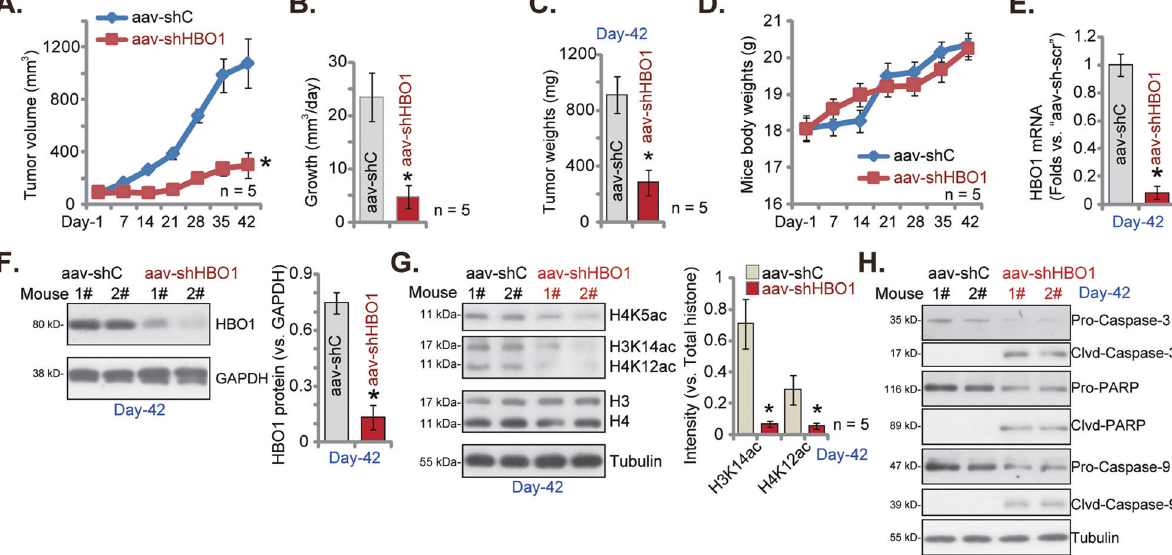
Fig. 8 HBO1 silencing hinders pPC-1 xenograft growth in nude mice. The pPC-1 xenograft-bearing nude mice were intratumorally injected with AAV-packed HBO1 shRNA ( “ aav-shHBO1 ” ) or AAV-packed scramble control shRNA ( “ aav-shC ” ). AAV was injected daily for 10 consecutive days. Tumor volumes ( A ) and mice body weights ( D ) were recorded every seven days ( “ Day-1 ” to “ Day-42 ” ), daily tumor growth (in mm 3 per day, B ) and tumor weights (at Day-42, C ) were measured as well. Expression of listed genes and proteins in the listed pPC-1 xenograft lysates were tested ( E , H ). Data were expressed as the mean ± standard deviation (SD). * P < 0.05 versus “ aav-shC ”